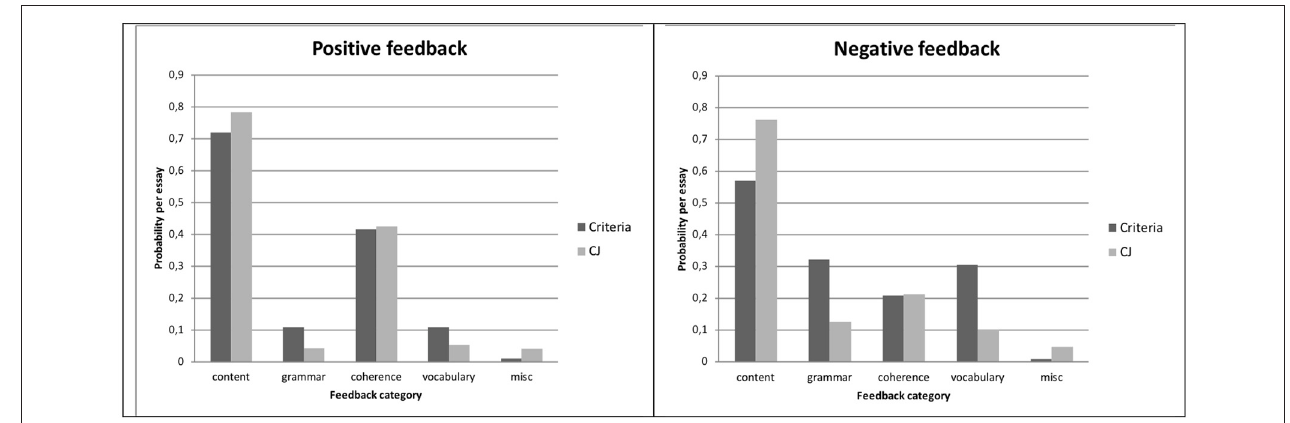
FIGURE 2 | Effects of condition (criteria vs. CJ) on the estimated probability of positive feedback (left pane) and negative feedback (right pane) for each of the five categories: content and structure, grammatical control, coherence and unity, vocabulary, and miscellaneous.